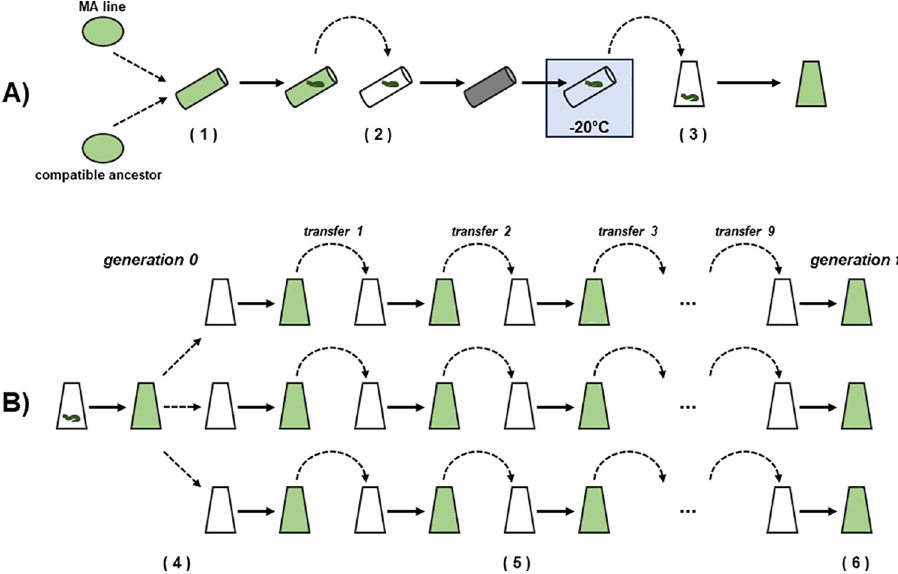
Fig 1. Schematic overview of the experimental procedure. A) Matings. Cell cultures of the MA line and the compatible ancestor were mixed in a falcon tube and incubated until zygote mats had formed (1). The zygote mats were transferred to new falcon tubes, incubated in the dark to allow zygote maturation and then frozen at -20˚C to kill off any vegatative cells (2). The culture with the matured zygote mat was transferred to a conical flask and incubated until zygotes germinated (3). B) Serial transfers. The germination culture was grown up until it was dense enough to start the three replicates and have enough cell material for DNA extraction. The three replicates were started with 1.2 ml of the original germination culture (4). Every three to four days 1.2 ml were transferred to fresh conical flasks and 2 ml of the remaining culture was used to measure OD (5). After nine transfers the end of the experiment was reached and the cells were collected for DNA extraction